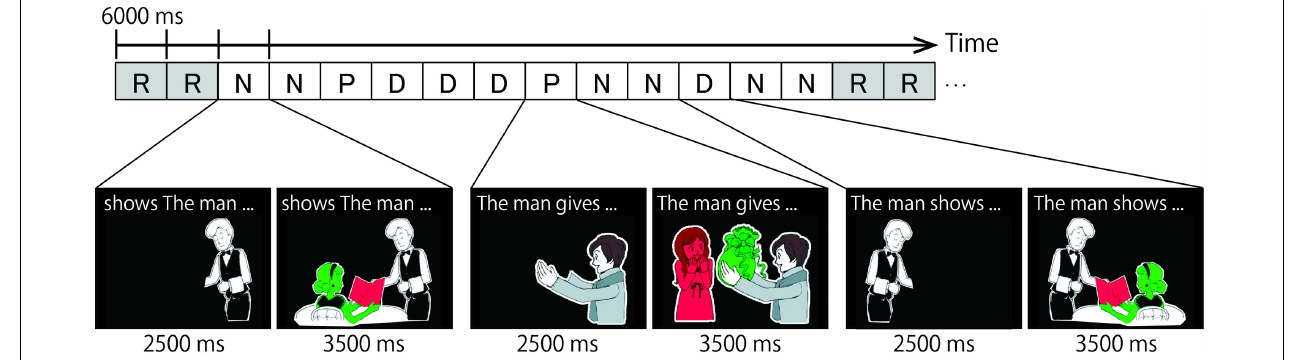
FIGURE 2 | Example of a task sequence. R, N, P, and D represent Rest, No structure, Prepositional Object (PO), and Double Object (DO) conditions, respectively. Each condition was presented for 6 s and consisted of two parts. In the first part, a cartoon of the actor was presented with a sentence fragment printed in the upper part of the screen. In the second part, participants were asked to describe the colored pictures by referring to the green object before the red object. For example in the P condition (i.e., the two cartoons show in the middle of the figure), participants first read the preamble “The man gives” silently while looking at the left cartoon. Next they were expected to say something like “the present to the woman” while looking at the cartoon on the